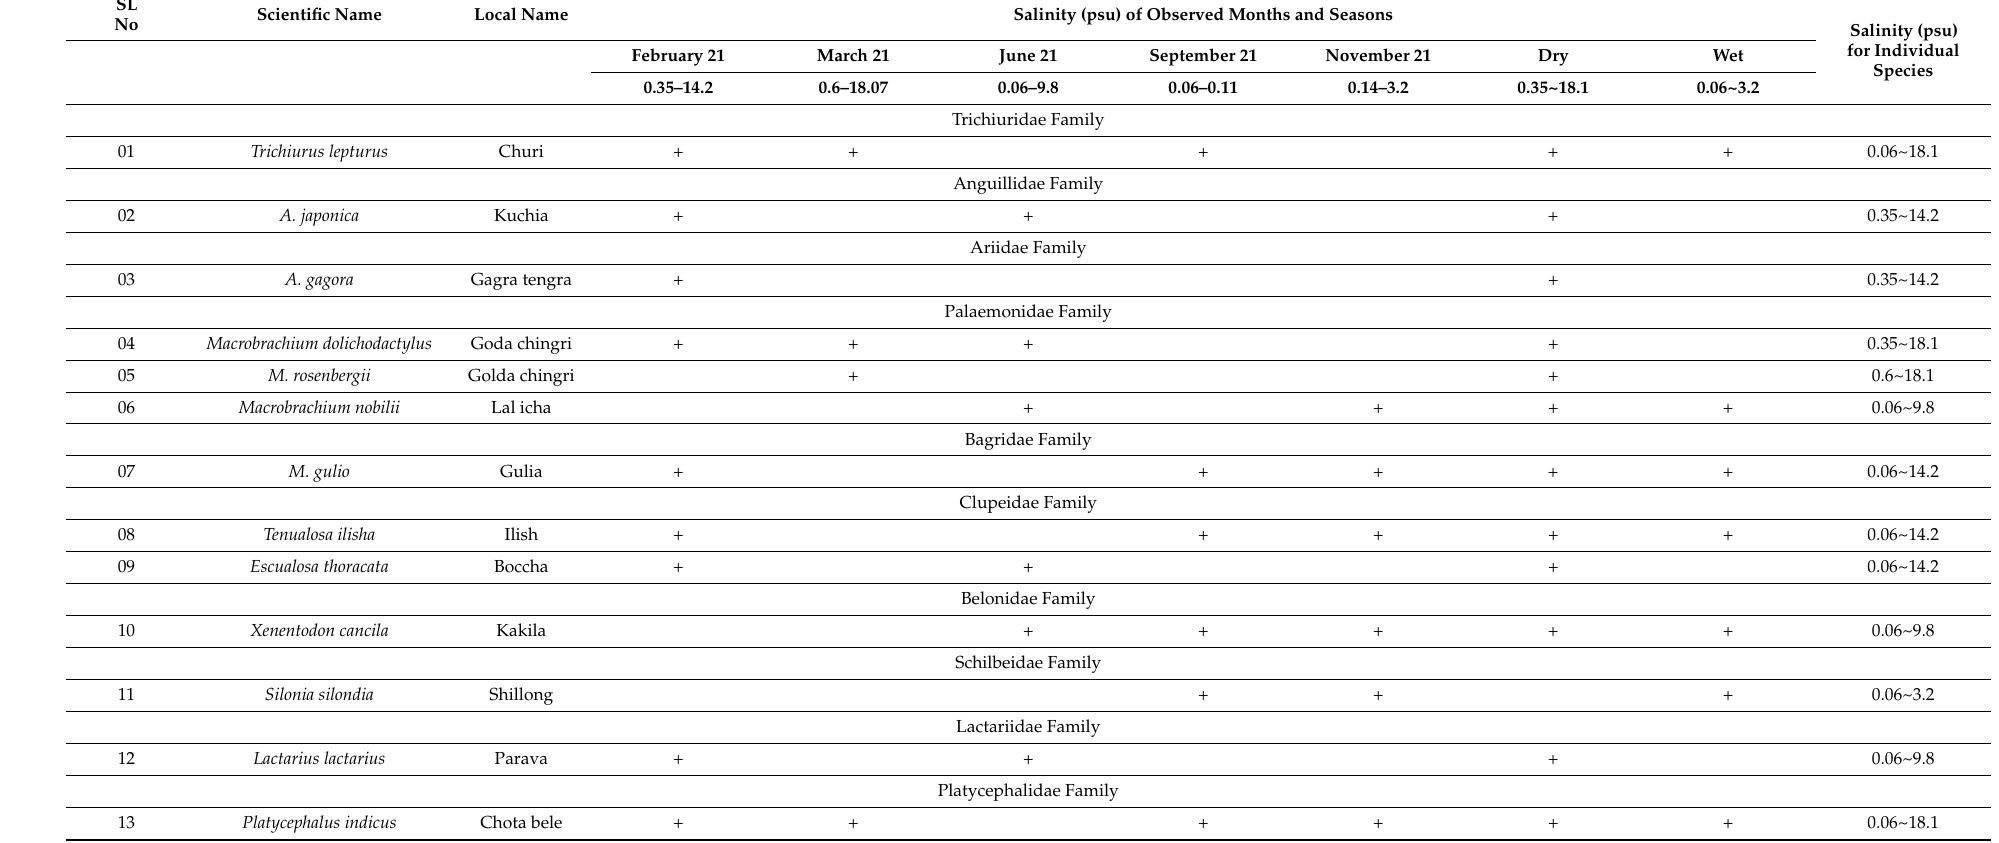
Table 2. Salinity tolerance level of fish species found in the Meghna River estuary